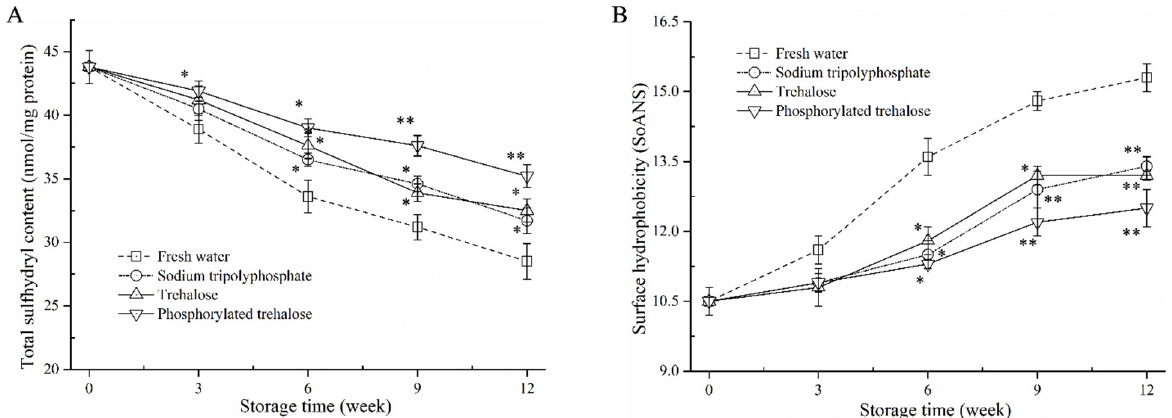
Figure 2. Total sulfhydryl content ( A ) and surface hydrophobicity ( B ) of MP in peeled shrimp soaked with fresh water, sodium tripolyphosphate, trehalose, and phosphorylated trehalose during frozen storage. * p < 0.05 and ** p < 0.01 compared with the fresh water treatment at the same point.